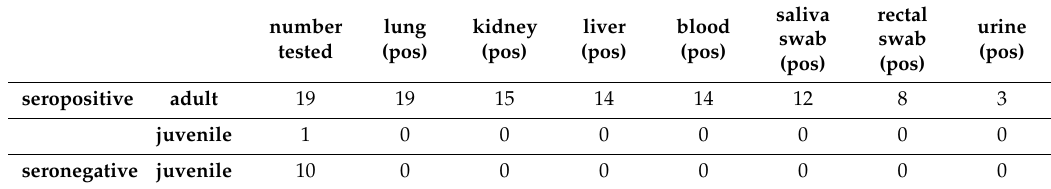
Table 1. Results of the rRT-PCR of 30 rats: 20 seropositive rats, including 1 juvenile, and 10 seronegative